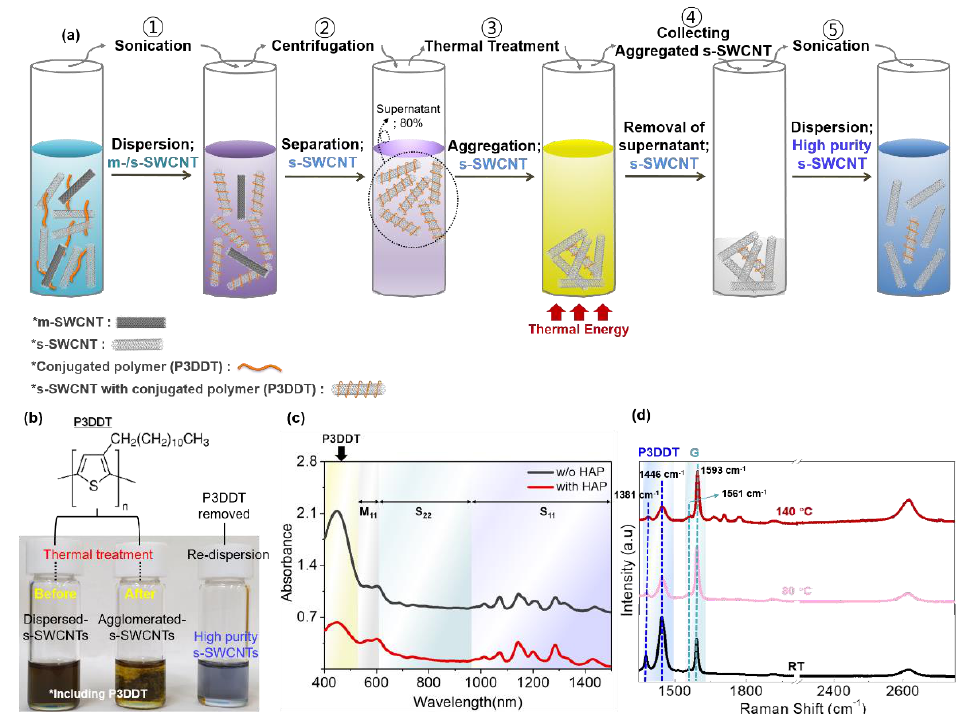
Figure 1. ( a ) High-purity s-SWCNT solution fabrication procedure; ( b ) Photographs of pristine, thermal treated pristine, and high-purity s-SWCNT solutions. The inset is a chemical structure of P3DDT; ( c ) Absorption spectra of the pristine and high-purity s-SWCNT; ( d ) Raman spectra of the pristine (black), 80 °C (pink), and 140 °C (red) temperature treated s-SWCNT at 532 nm excitation. To determine the effects of heat-assisted purification of s-SWCNTs on their electrical properties, bottom-gate/bottom-contact structure FETs were fabricated. As channel layers, s-SWCNTs obtained with and without the HAP process were used. Here, Al 2 O 3 was used as a gate dielectric layer and the channel width (W) and length (L) of the FETs were 100 and 10 μm, respectively (Figure 2a). From the atomic force microscopy (AFM) analysis, it was confirmed that the s-SWCNT film had a uniform two-dimensional network structure with root-mean-square roughness of approximately 1.01 nm. The areal density of s- SWCNTs was >20 nanotubes per μm 2 . Figure 2b,c shows the transfer characteristics of SWCNT FETs without and with the HAP process, respectively. The HAP-processed